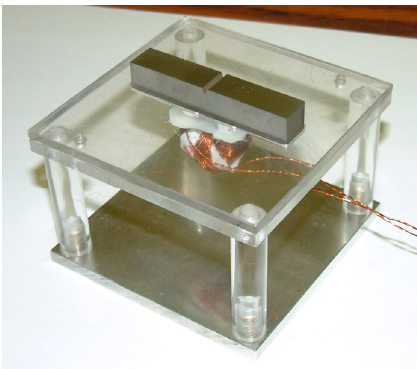
Figure 2. Photo of the sample holder. A Charpy sample is placed on the top (V-notch is opposite to the magnetizing yoke.